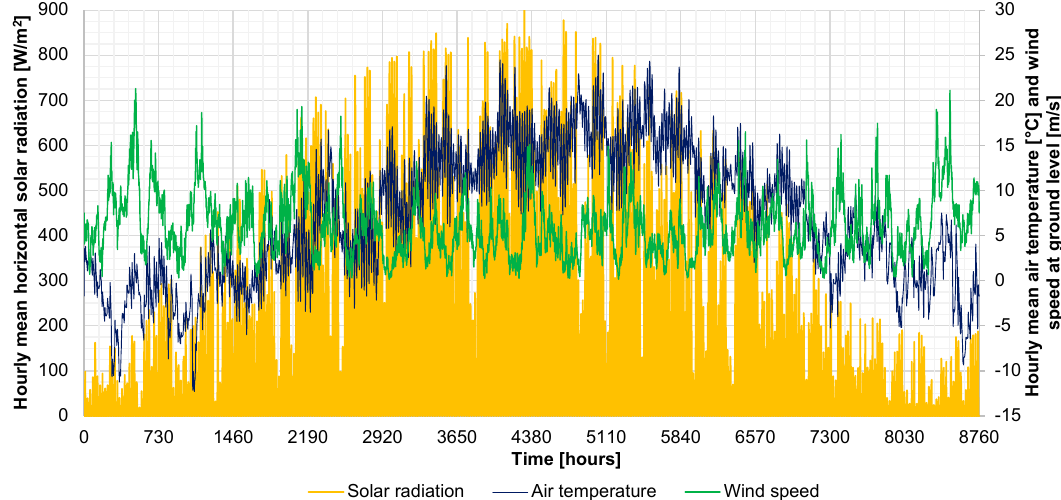
Figure 3. The mean hourly air temperature, horizontal solar radiation, and wind speed at ground level for Gdansk locality.